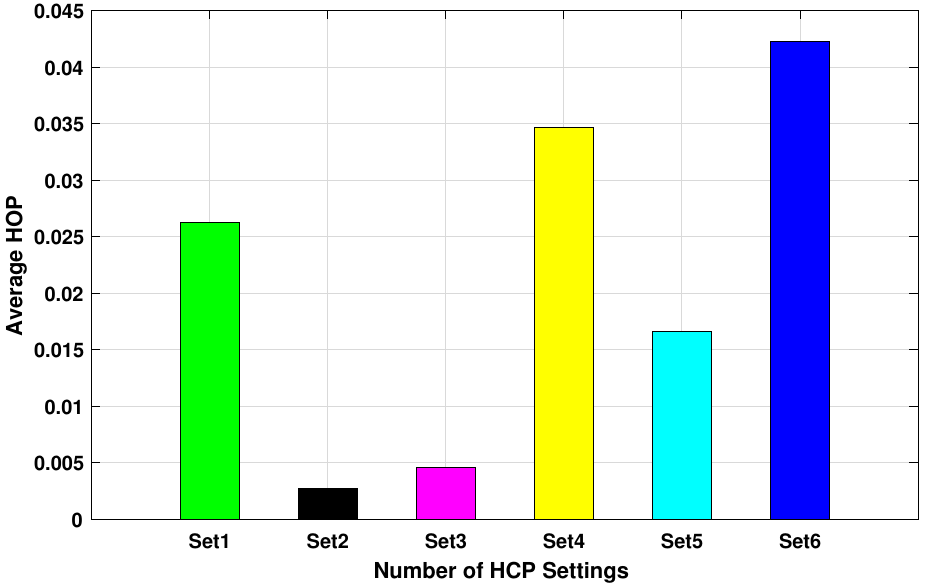
Figure 3. Overall average HOP vs. HCP setting